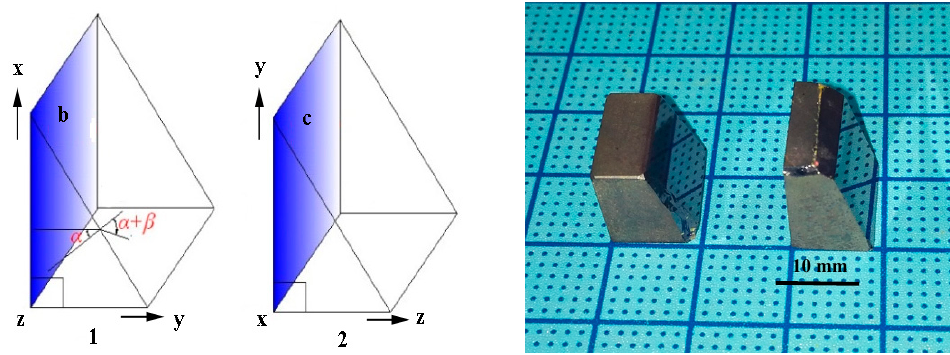
Figure 2. Schematic ( left ) and photograph ( right ) of Prism 1 and Prism 2.